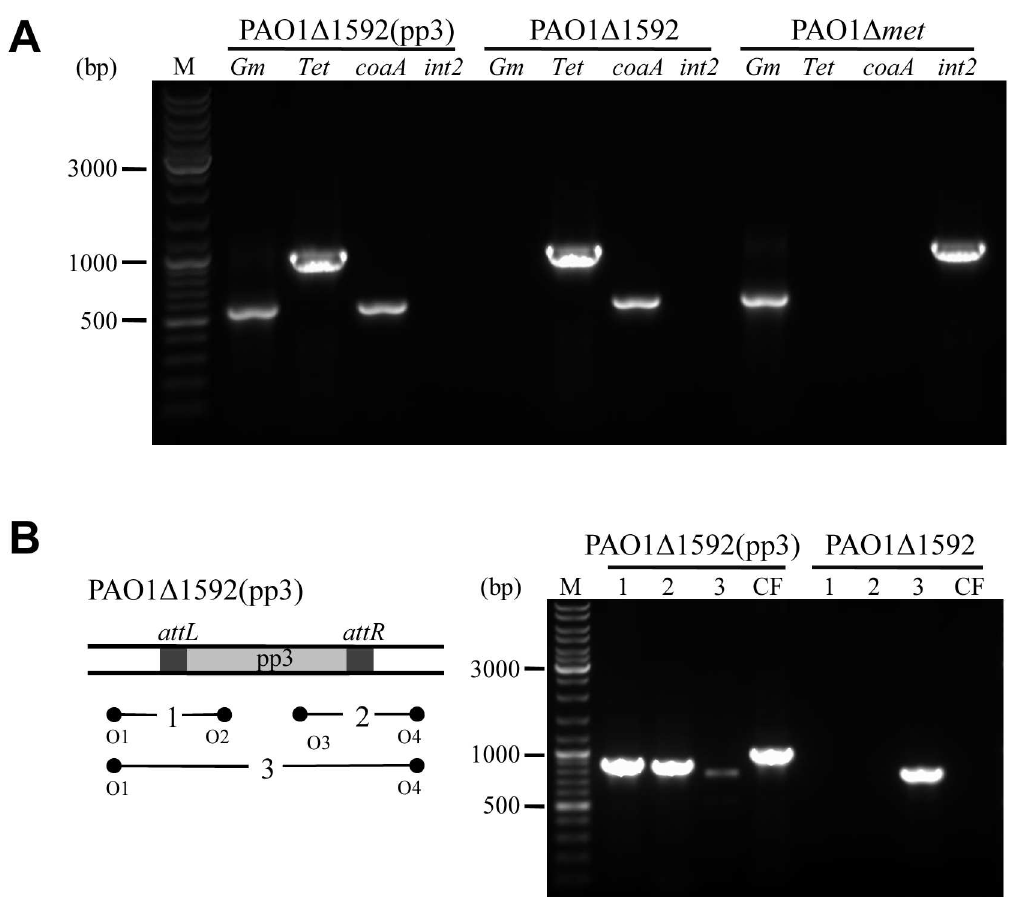
Fig 4. Interstrain transfer of prophage pp3 between P . aeruginosa strains. (A) PCR analysesof strains used to test horizontaltransfer of pp3 from PA1 to PAO1 (see text for detailedstrain descriptions). LaneM containsa DNA size marker. (B) Confirmation of pp3 integrationinto the predicted attachment site in strain PAO1. The diagram on the left shows the expectedPCR products. Lanesmarked CF represent the circular form of pp3. Lane M containsa DNA size